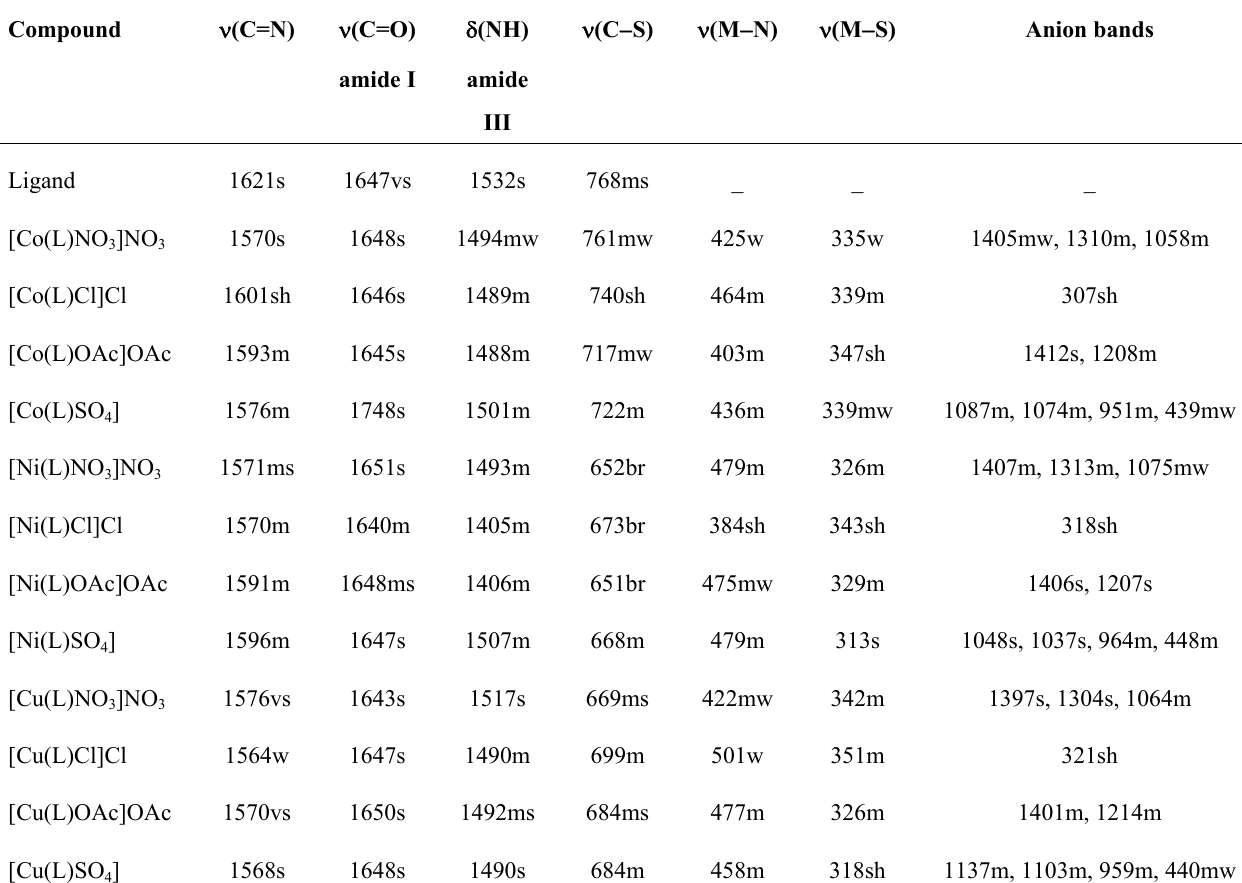
Table 3. Selected IR bands of Schiff’s base ligand and its